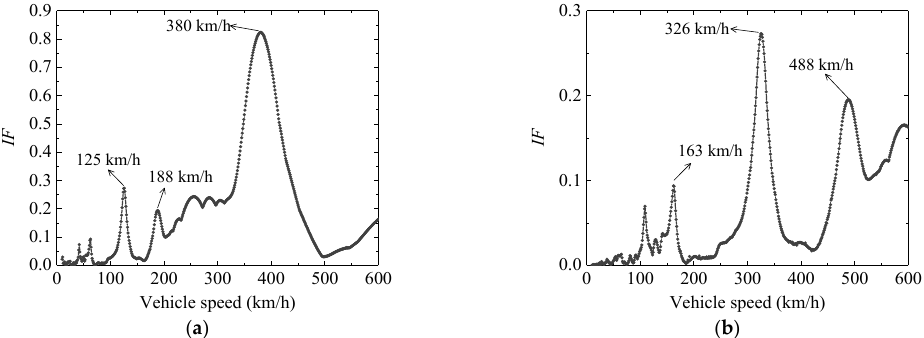
Figure 7. Dynamic impact factor ( IF ) of bridge spanning 25 m: ( a ) IF of vertical displacement; ( b ) IF of radial